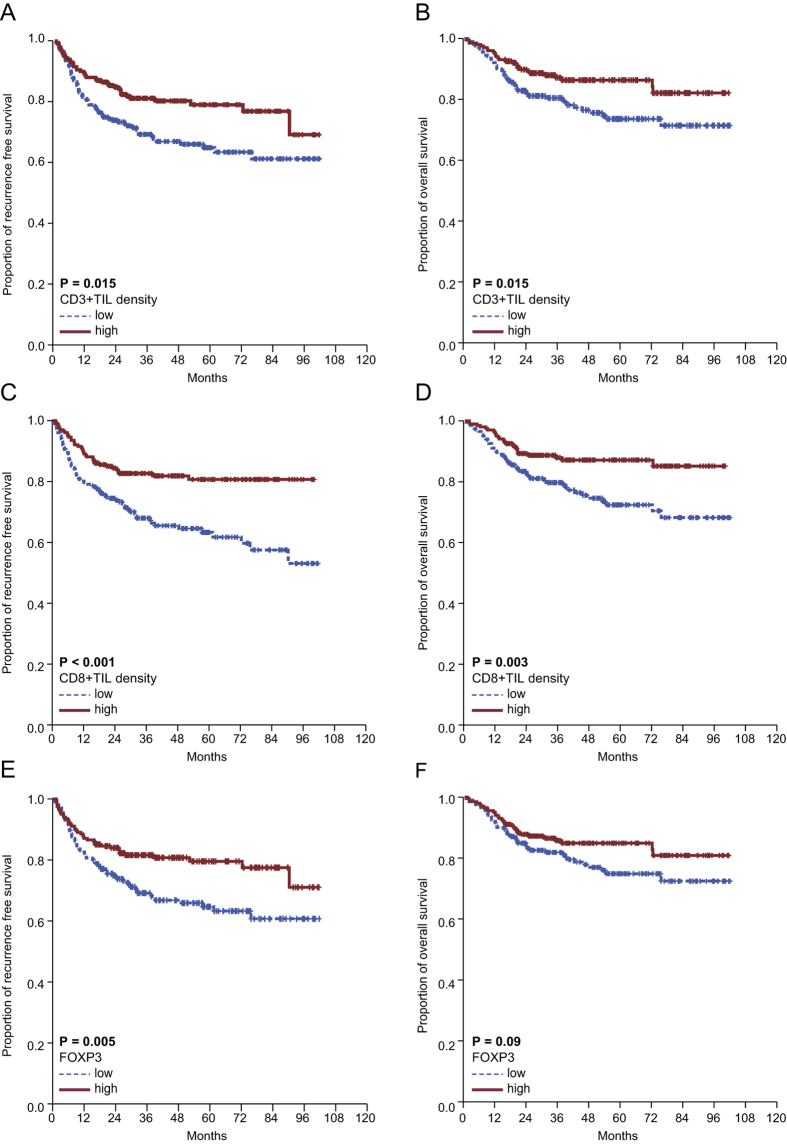
The 402 included patients were assigned to one of two groups based on specific subsets of T lymphocytes.(A) The 5-year RFS rate was 65.0% for low CD3+ vs. 79.1% for high CD3+; P = 0.005. (B) The 5-year OS rate was 73.5% for low CD3+ vs. 86.3% for high CD3+; P = 0.01. (C) The 5-year RFS rate was 63.3% for low CD8+ vs. 80.7% for high CD8+; P < 0.0001. (D) The 5-year OS rate was 72.4% for low CD8+ vs. 87.1% for high CD8+; P = 0.003. (E) The 5-year RFS rate was 64.7% for low Foxp3 Treg vs. 79.5% for high Foxp3 Treg; P = 0.05. (F) The 5-year OS rate was 74.8% for low Foxp3 Treg vs. 84.9% for high Foxp3 Treg; P = 0.09.